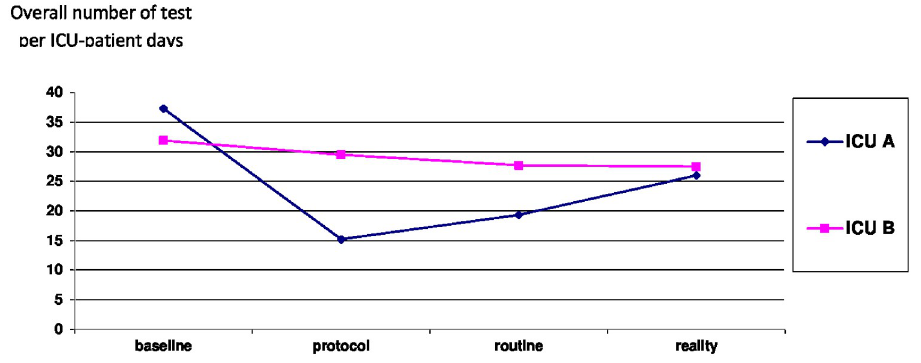
Fig 2. Comparison of the number of test per ICU-patient days between ICU A and B.